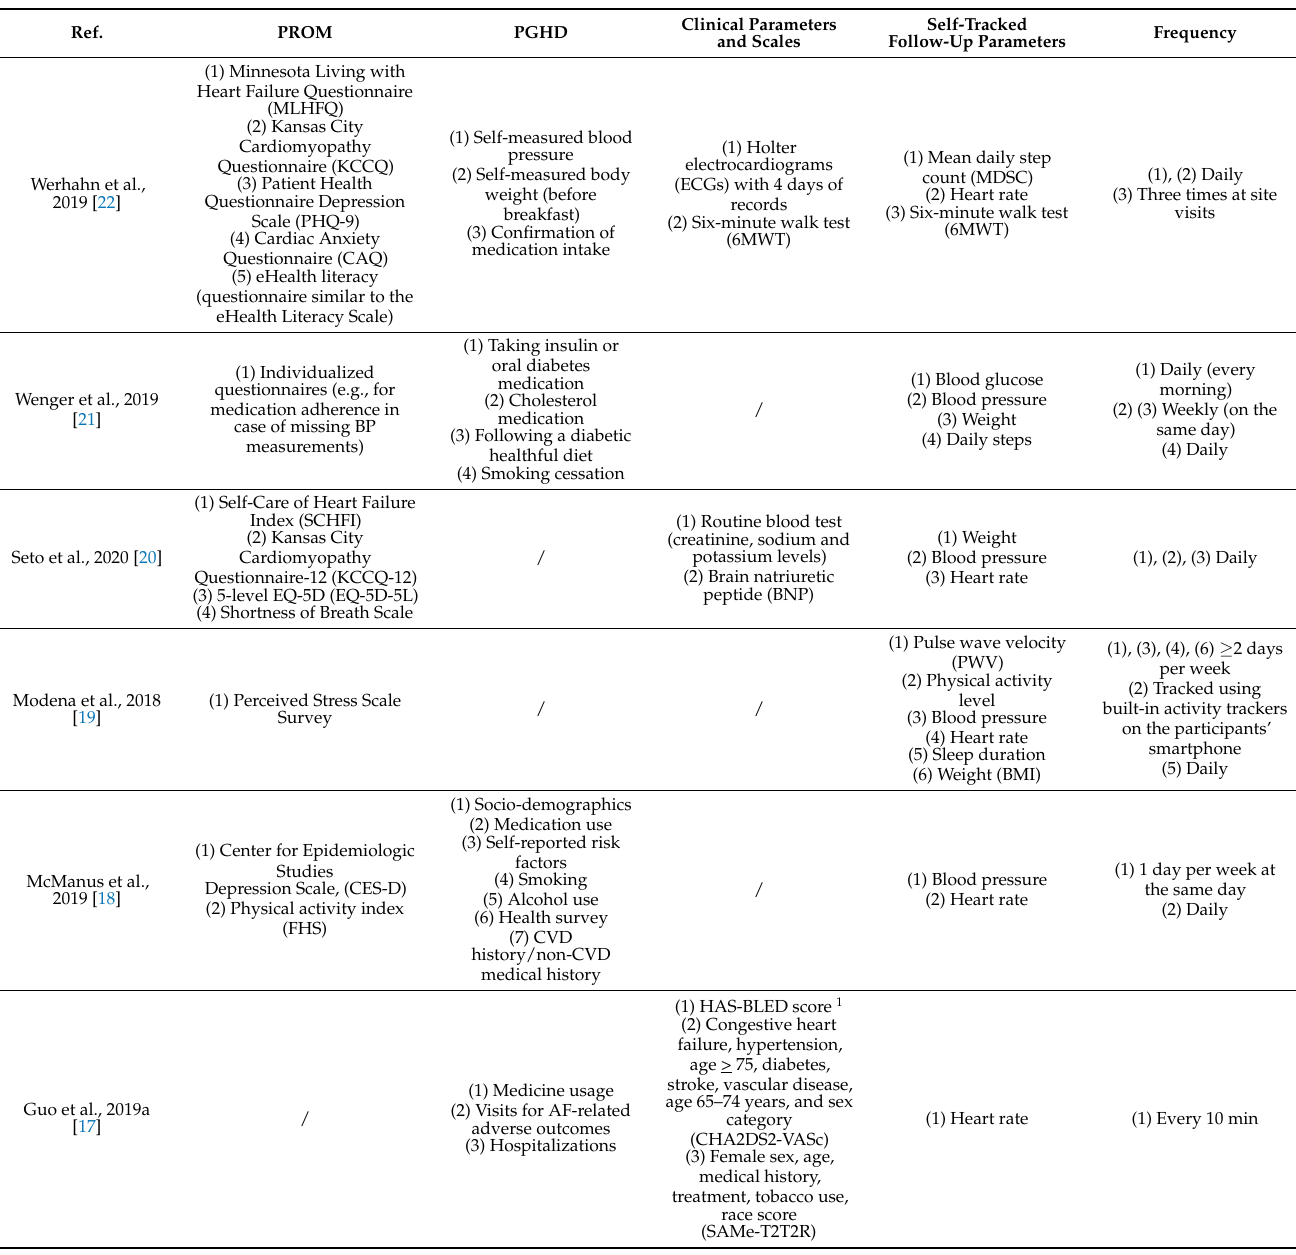
Table 4. Overview of the studies included in the systematic review, with a focus on the qualitative and quantitative parameters. Ref. Clinical Parameters and